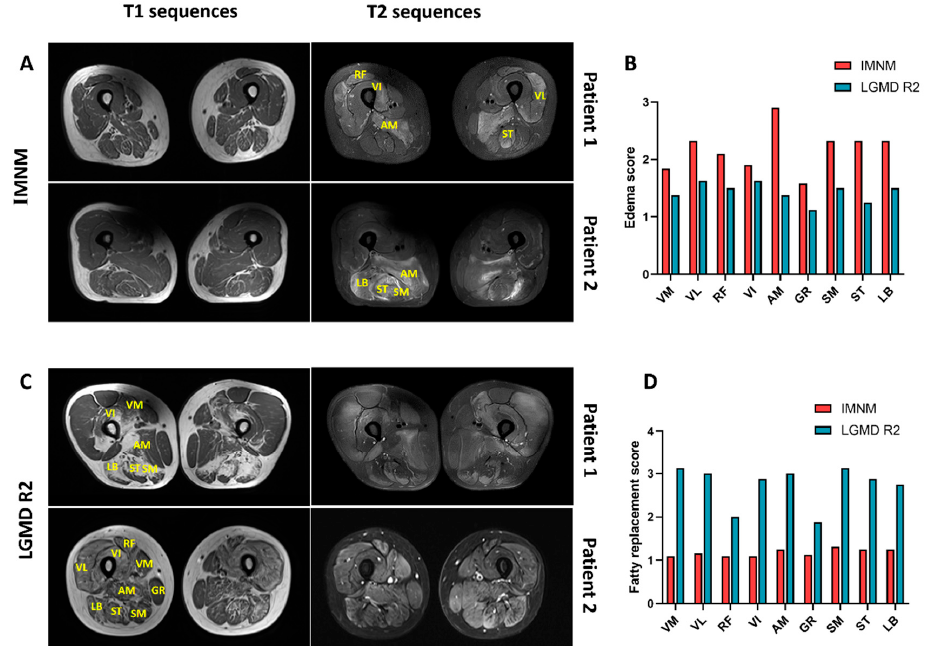
Figure 1. Representative thigh muscle MRI of IMNM and LGMD R2. ( A ) Slight or no fatty replace- ment on T1 images and a marked T2 hyperintensity in patients with IMNM. ( B ) Muscle edema with adductor magnus (AM) prominently affected. ( C ) Extensive fatty replacement on T1 images and slight T2 hyperintensity in patients with LGMD R2. ( D ) Fatty replacement occurred in all three compartments of the thigh. Note: VM: vastus medialis; VL: vastus lateralis; RF: rectus femoris; VI: vastus internus; GR: gracilis; SM: semimembranosus; ST: semitendinosus; LB: long biceps femoris. IMNM: n = 31; LGMD R2: n = 8.